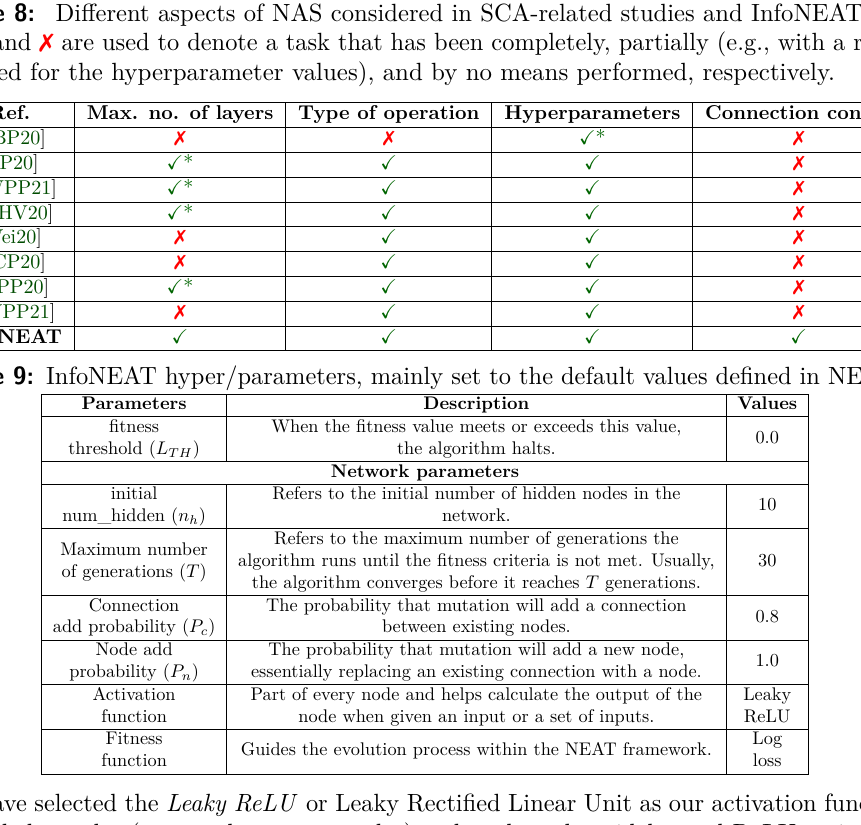
Table 8: Different aspects of NAS considered in SCA-related studies and InfoNEAT. ( ✓ , ✓ *, and ✗ are used to denote a task that has been completely, partially (e.g., with a range defined for the hyperparameter values), and by no means performed, respectively. Ref.